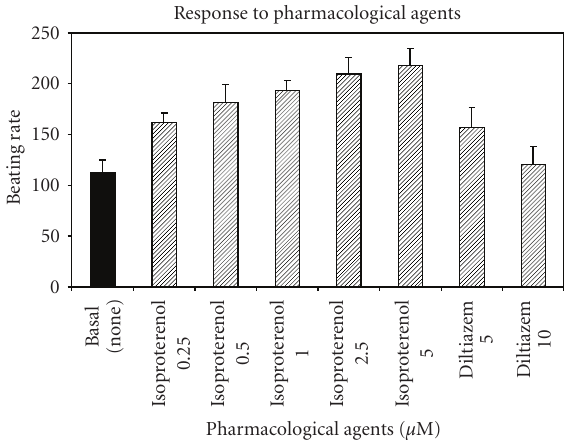
Figure 5: Chronotropic response of contracting cells to adrenergic and dilthiazem stimulation. Isolated cells were plated into 6-well plate for 28 days. Basal beating rate was recorded. Contracting rate was measured by the treatment with the β -adrenergic agonist isoproterenol and antagonist dilthiazem. Results represent the mean of 6 to 10 separate